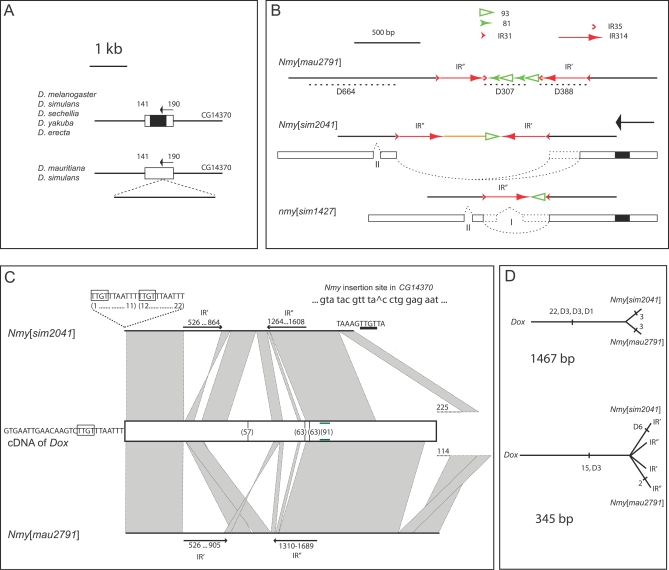
The Molecular Structure and Evolution of Nmy
(A) An incomplete survey of Nmy/CG14370 alleles found in species of the D. melanogaster subgroup. CG14370 is a single-exon gene in most species, but various inserts are found in D. simulans and D. mauritiana that represent alleles of Nmy. Arrow: transcription orientation; rectangle: transcripts; filled: coding sequence; empty: untranslated region. The status of translation in D. simulans and D. mauritiana is unclear.(B) Comparison of the three Nmy inserts found in D. mauritiana and D. simulans. For each allele, solid lines indicate the genomic sequence with various sequence components marked with symbols (e.g., an empty triangle for a 93-bp element). For Nmy[sim2041] and nmy[sim1427]. Partial transcripts of various lengths are shown as rectangles (filled: coding sequence as in CG14370 but with earlier termination; dotted: alternative transcripts). Black arrow indicates transcription orientation. Two likely alternatively spliced introns (I and II) were identified. Possible spurious reverse-transcription products were also indicated (curved dotted line, see Text S3 for more details).(C) Origin of Nmy inserts by retrotransposition. The cDNA of Dox, Nmy[sim2041], and Nmy[mau2791] are compared and the paralogous regions are highlighted (parallelogram; its twisted form for reverse orientation). The positions of three introns of 57, 63, and 63 bp (vertical broken bar with intron size) and an alternative intron of 91 bp (horizontal green bar) from Dox are shown. Nucleotides at the 5′ ends of the two Nmy alleles and the cDNA of Dox are shown; also shown are the 3′ end of Nmy[sim2041]. Eleven nucleotides, TTGTTTAATTT, near the 3′ end of the Dox transcription were duplicated during the retrotransposition event. The insertion site within CG14370 for the retrotranspostion is also shown. The dinucleotide, TA, before the insertion target (^) was also duplicated, but the nearby tetranucleotides TTGT (underlined) might not be related to the other TTGT (framed). The 3′ end sequences from both Nmy alleles fail to match to the extant cDNA of Dox, but the sequence does match to the genomic regions 114 and 225 bp upstream of Dox, respectively (dotted lines with the number of 114 or 225). The left-hand inverted repeat IR' was most likely generated as a secondary duplication after the retrotransposition event.(D) Both Nmy[sim2041] and Nmy[mau2791] evolved from a common retrotransposed sequence of Dox. Upper: Homologous sequences of 1,467 bp among Dox, Nmy[sim2041], and Nmy[mau2791] were used to construct a star phylogeny with the number of single nucleotide substitutions as well as the three insertions/deletions of 1–3 nucleotides (D3, D3, and D1) mapped on the branches. Lower: Homologous sequences of 345 bp among the two inverted repeats of Nmy[sim2041], Nmy[mau2791], and Dox were used to construct another star phylogeny. The four inverted repeat sequences are essentially identical except for a 6-bp deletion (D6) in IR' of Nmy[sim2041], and two nucleotide substitutions in IR'' of Nmy[mau2791].